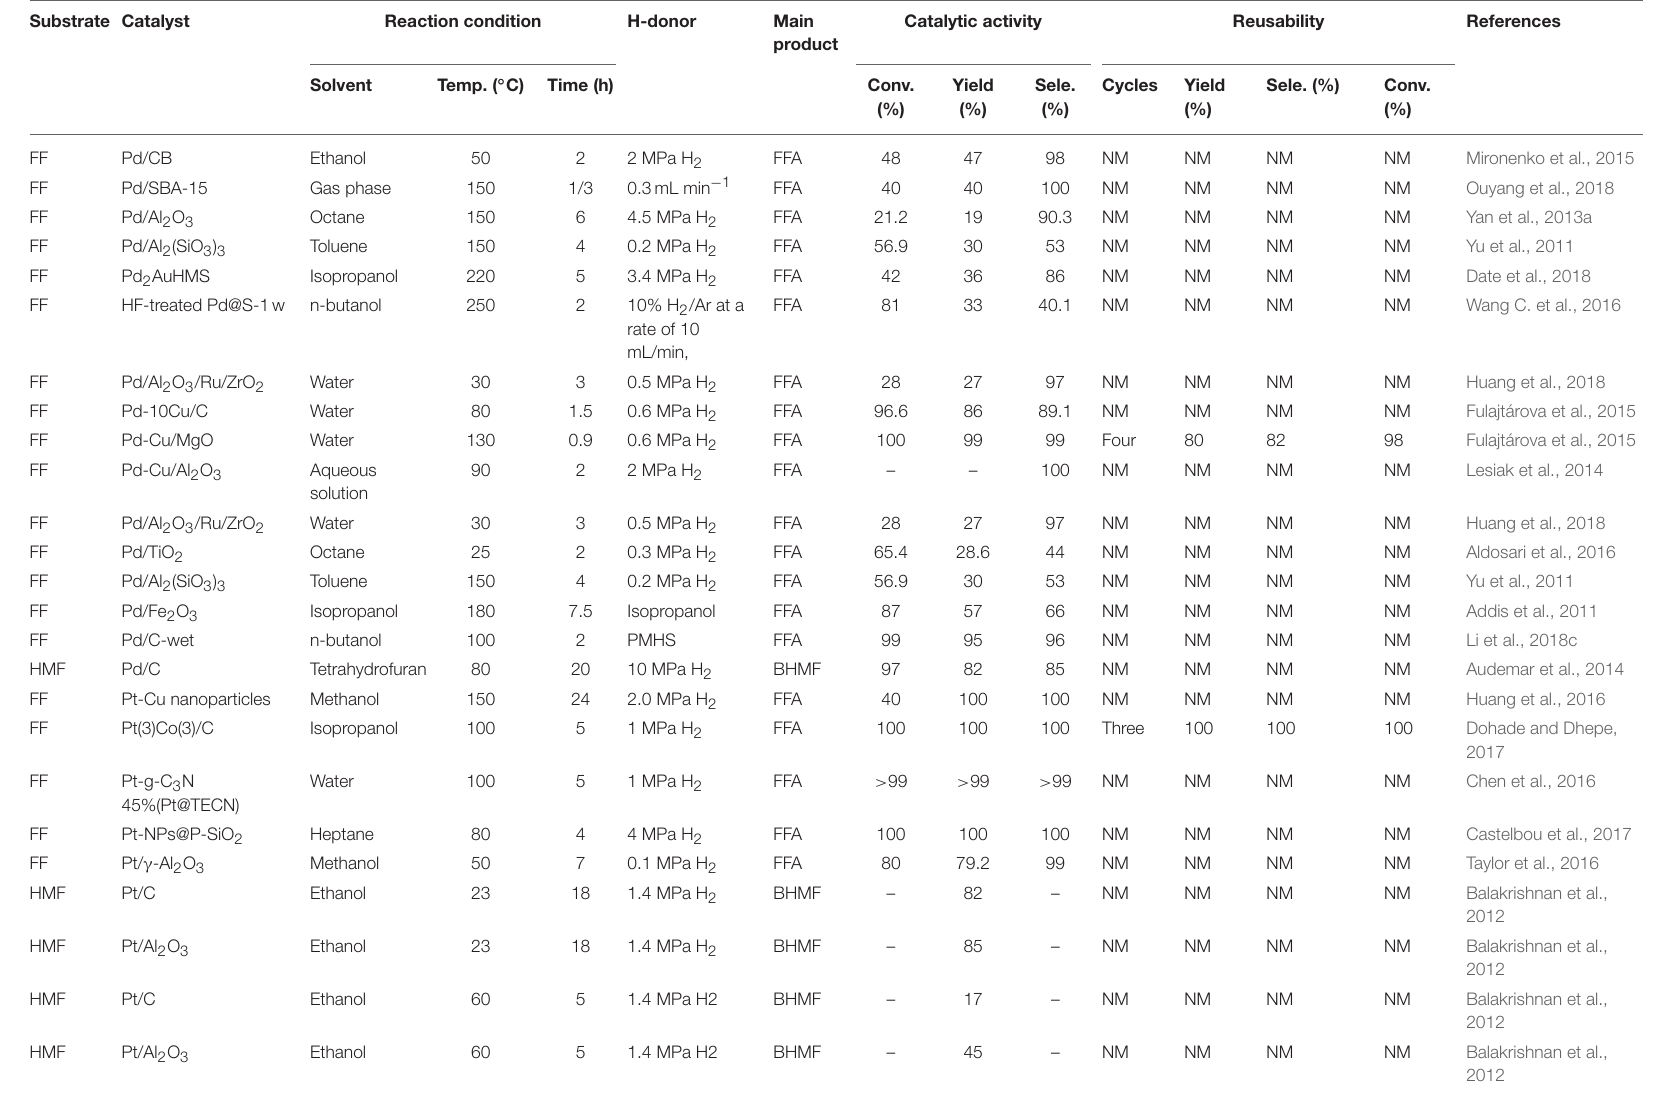
TABLE 2 | Reduction of FF and 5-hydroxymethylfurfural catalyzed by different precious metallic catalysts. Substrate